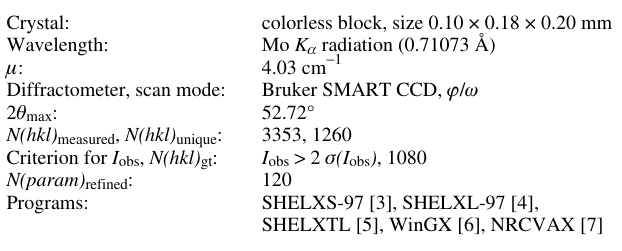
Table 1. Data collection and handling.